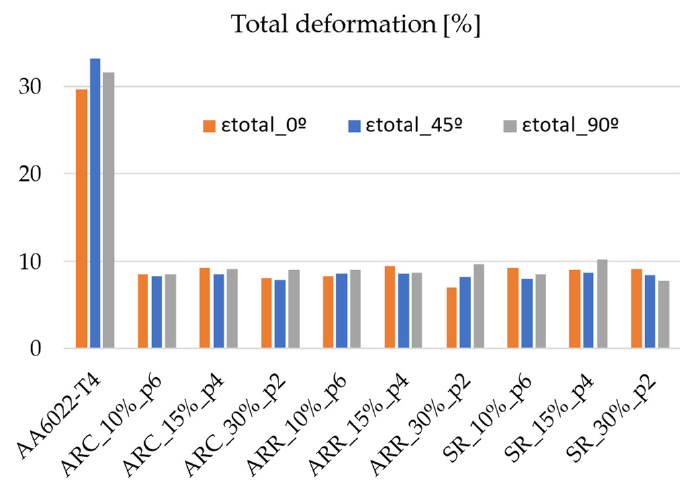
Figure 9. Evolution of total deformation with rolling conditions.